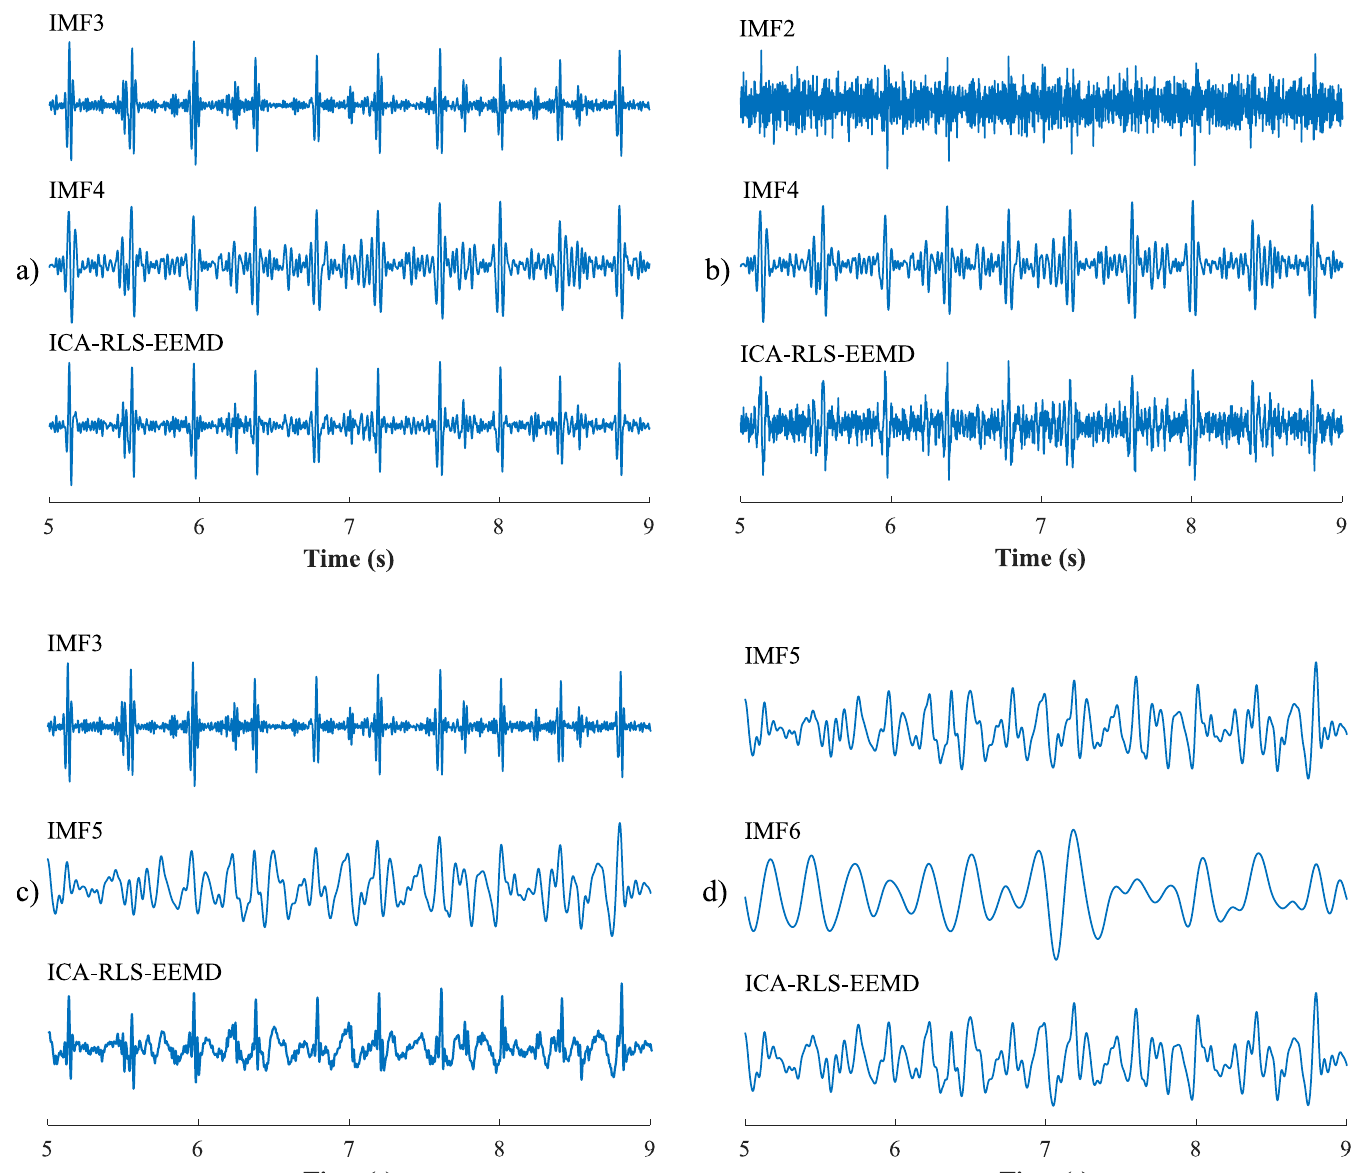
Fig 21. Influence of the IMF selection on the final fECG signal quality: a) the optimal selection of IMFs, b) inappropriate selection of IMF2 component representing noise, c) inappropriate selection of both IMFs leading to insufficient suppression of mECG residues, d) inappropriate selection of IMFs, where both signals contain very little information on fECG